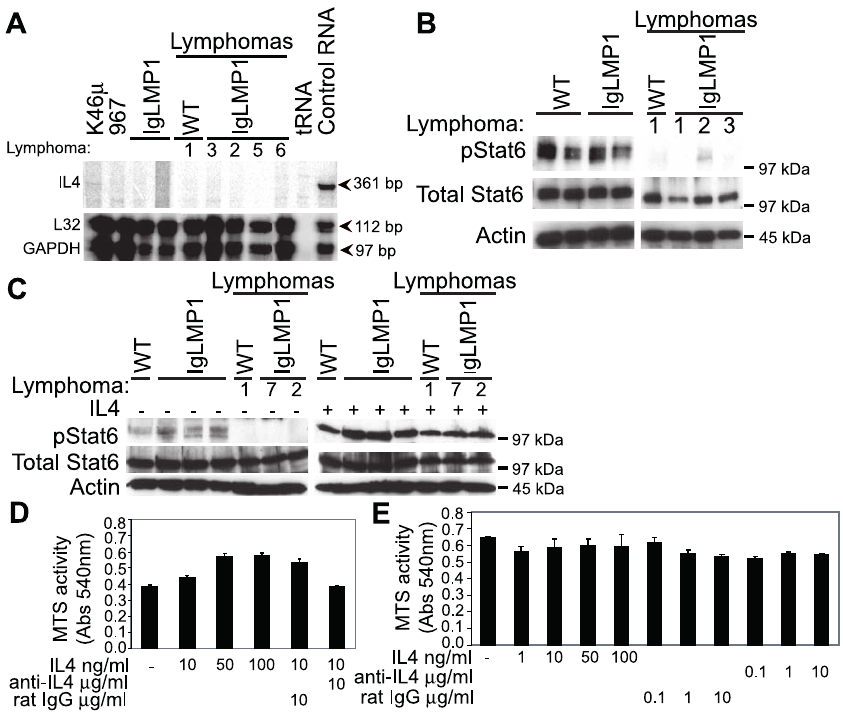
Figure 4. Wild-Type and LMP1 Transgenic Lymphoma Cells Survive Independently of IL4/Stat6 Signaling in Culture (A) Rnase protection assay for IL4 mRNA from purified B cells (CD19 þ ) from WT and LMP1 transgenic splenocytes. The L32 and GAPDH housekeeping genes were used as a loading control. Arrow indicates the position of the protected probe. (B and C) Immunoblot analysis of WT and LMP1 transgenic mice for activated pStat6 in (B) purified B cells (CD19 þ ) at the time of harvest or in (C) whole splenocytes cultured with or without IL4. (B) Actin was used as a loading control, and the white line indicates that intervening lanes have been spliced out. (D and E) MTS assay of (D) WT lymphocytes and (E) LMP1 transgenic lymphoma cells cultured with IL4, a neutralizing antibody to IL4, or a rat IgG isotype control at the indicated concentrations. Shown are the results from LMP1 transgenic lymphoma 3. The results are the mean 6 SEM of triplicate samples from a single representative experiment that was repeated twice with similar results.